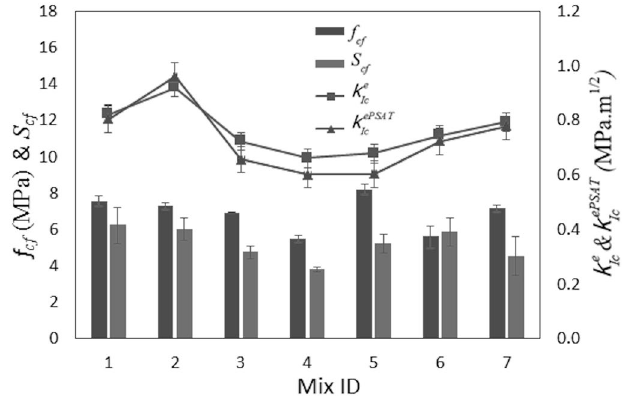
Figure 3. Flexural strength ( f ), shear stress concentration factor ( S cf ) and fracture toughness ( K Ice and K IcePSAT ) cf for the concrete specimens subjected to 28 days curing.